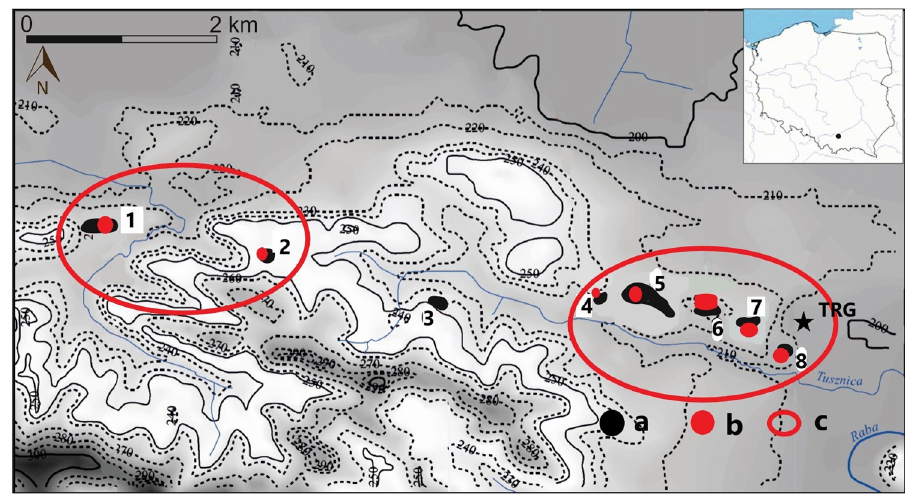
Figure 1: Targowisko settlement region. Early Neolithic sites with relics of houses: ( 1 ) Zagórze 2, ( 2 ) Brzezie 17, ( 3 ) Brzezie 40, ( 4 ) Szarów 9, ( 5 ) Targowisko 16, ( 6 ) Targowisko 14 – 15, ( 7 ) Targowisko 12 – 13 and ( 8 ) Targowisko 10 – 11; TRG – core with biogenic deposits; ( a ) LBK sites, ( b ) MC sites and ( c ) MC settlement